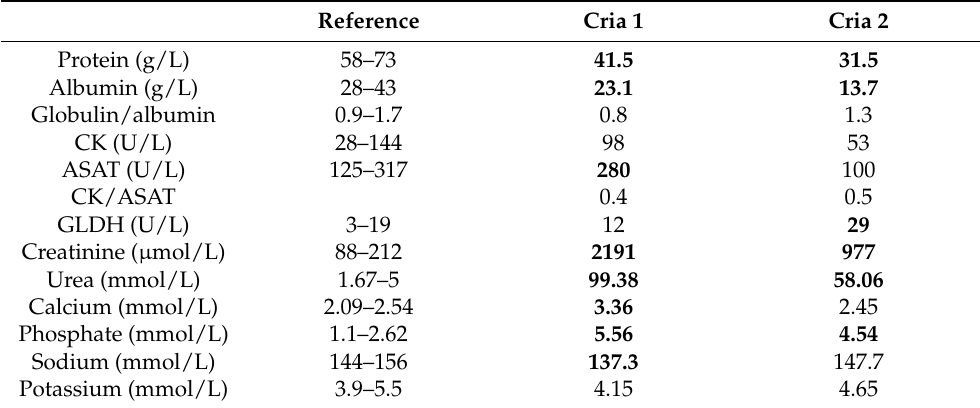
Table 4. Kidney function analysis. Plasma values. Cria 1, day 15 after vitamin D3 injection; Cria 2, day 16 after vitamin D3 injection. Reference values derive from Dawson et al. (2011) and were for alpacas. Values that differ from the references are displayed bolded. CK, creatine kinase; ASAT, aspartate transaminase; GLDH, glutamate